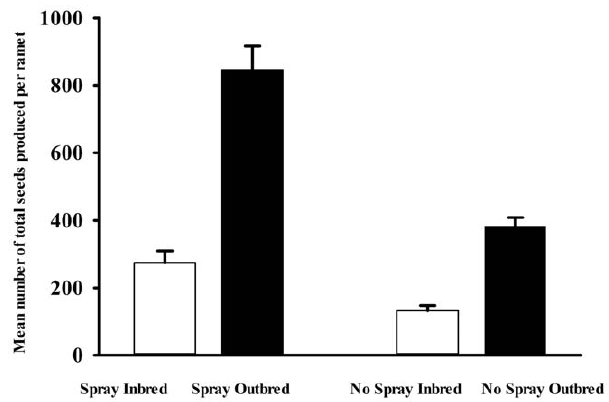
Figure 1. Mean + / 2 SE for the number of total seeds produced per ramet among inbred and outbred plants on spray (bi- weekly insecticide applications) and no-spray fields during the second growing season.